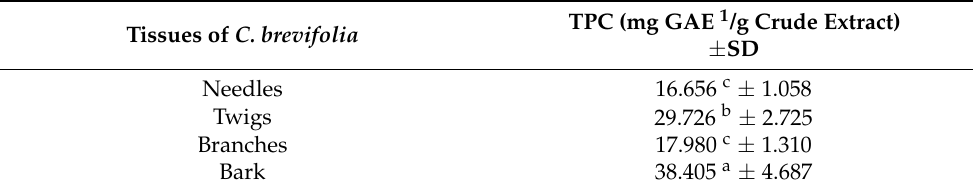
Table 2. Total Phenolic Content (TPC) of methanol extracts of different types of tissue of C. brevifolia using the Folin–Ciocalteu method 1 .